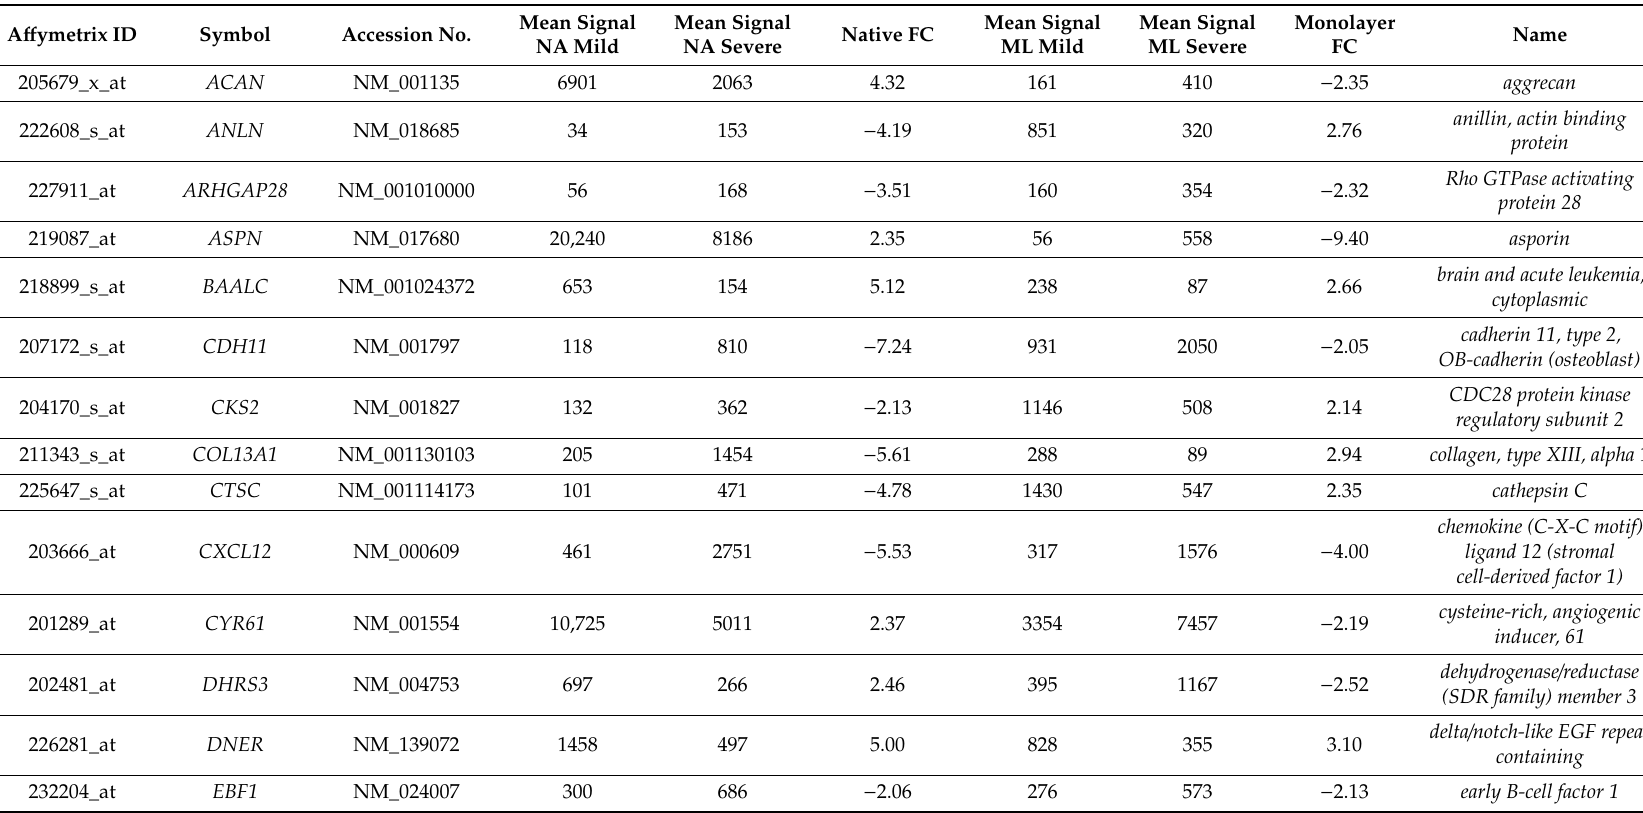
Table 1. Genes with di ff erent expressions in both mild vs. severe degenerated anulus fibrosus (AF) tissue (NA) and in monolayer cells (ML) from mild vs. severe degenerated AF tissue (35